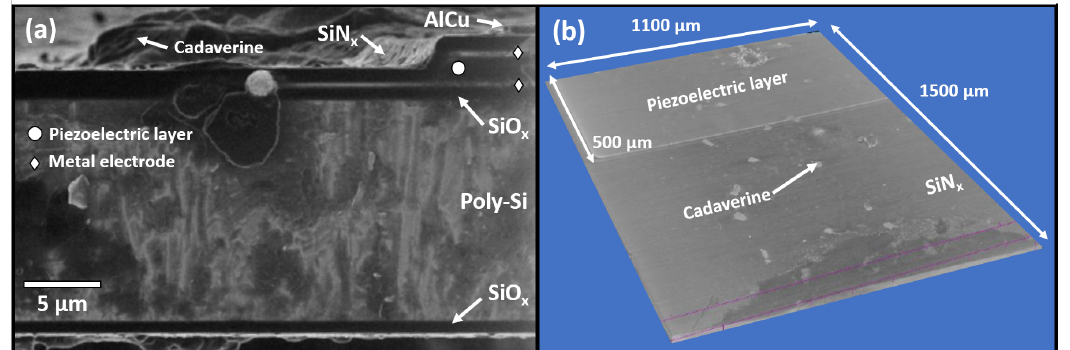
Figure 13. ( a ) Ion-beam microscopy image of cantilever cross-section, showing the different material layer thicknesses. ( b ) X-ray nanotomography top view of the cantilever, showing the material dimensions. Cadaverine spots can be observed in both